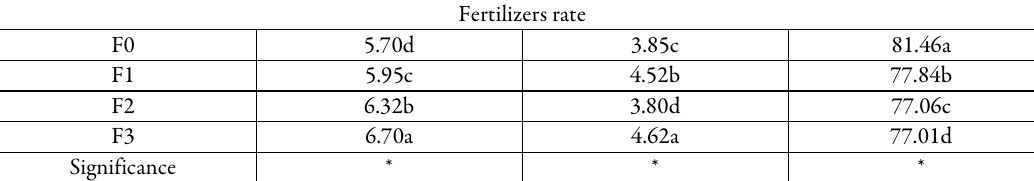
* * * Means followed by the same alphabets along rows are not significantly different at 5% level of